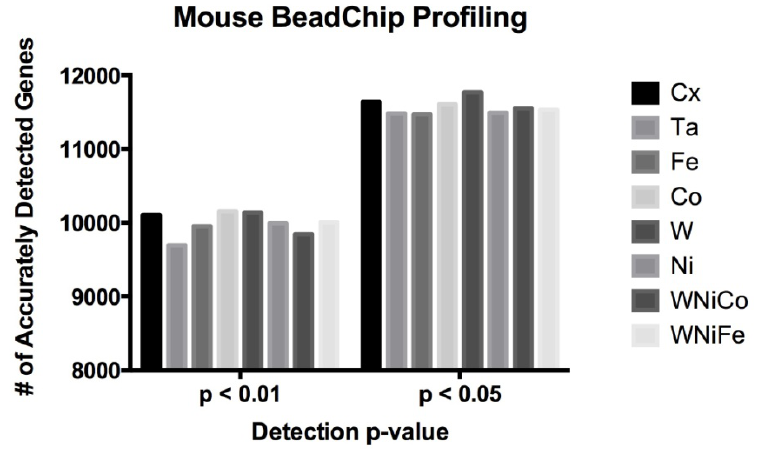
Figure 2. Mouse data comparison between actual numbers of features accurately expressed in each exposure group at the detection p -value ≤ 0.05 and ≤